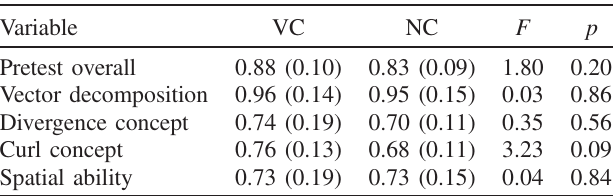
TABLE II. Students ’ prior achievement (mean and